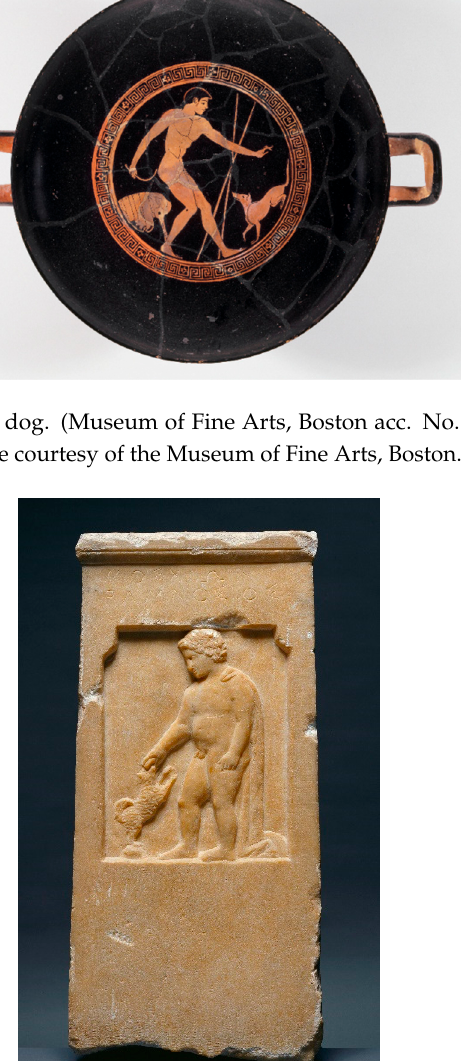
Figure 19. Moschion stela. The J. Paul Getty Museum, Villa Collection, Malibu, California, 73.AA.117. Digital image courtesy of the Getty’s Open Content Program.